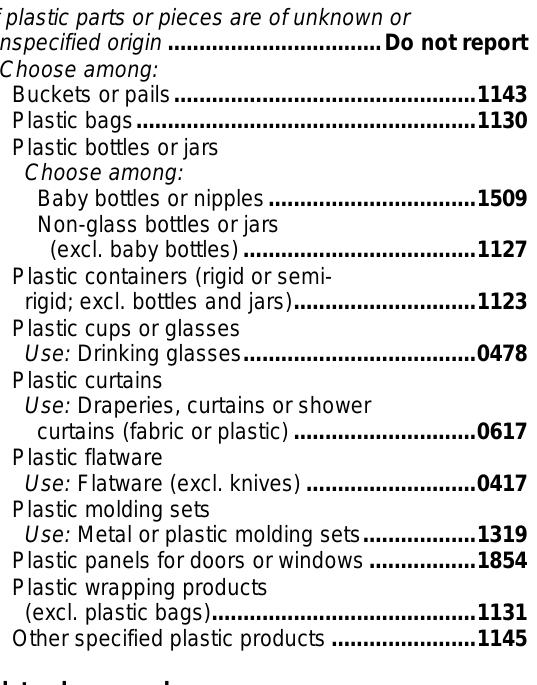
Plates or platters (excl. paper plates) Use: Tableware and accessories Plates, paper Use: Paper products (excl. bags, cups, Platform tennis Use: Squash, racquet ball or paddle ball Platforms Choose